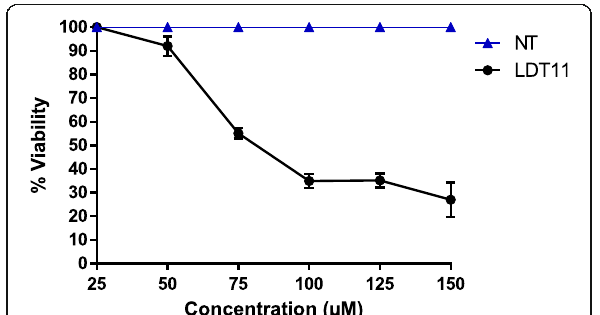
Fig. 4 Cell viability test by the Neutral Red Uptake Assay in RAW264.7 cell line, using different concentrations of the phenolic derivative, LDT11. NT - untreated cells. LDT11 - cells treated with LDT11 and then with